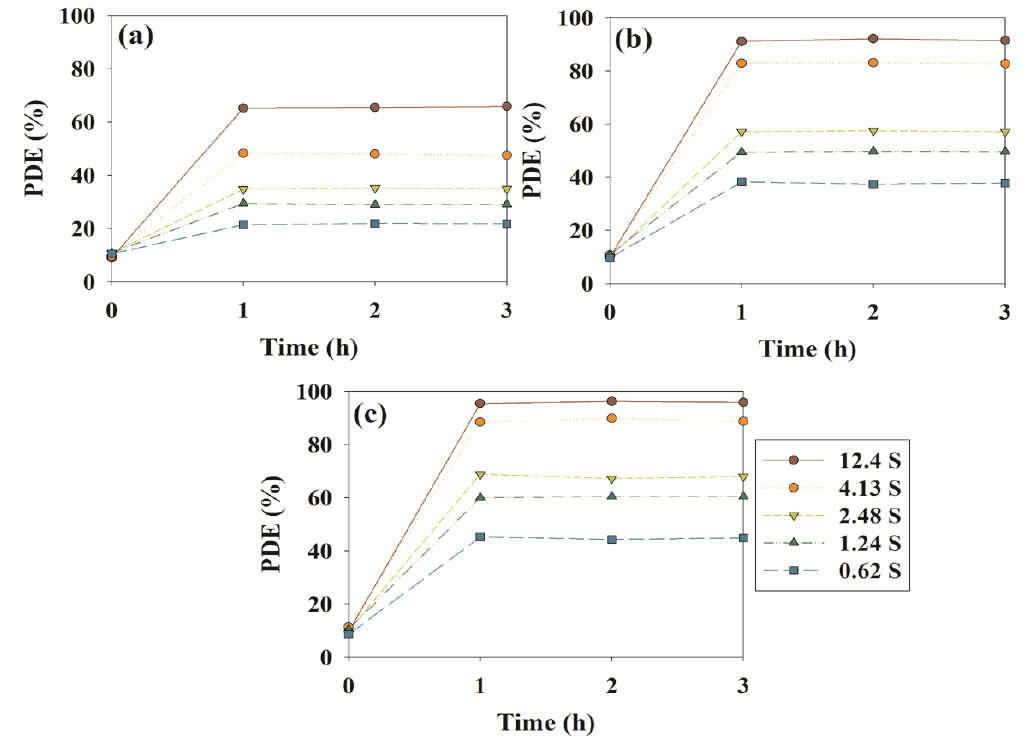
Figure 5. Time-series photocatalytic degradation efficiencies (PDEs, %) of ( a ) toluene, ( b ) ethyl benzene and ( c ) o-xylene as determined using N–F–TiO 2 -6, according to retention time.